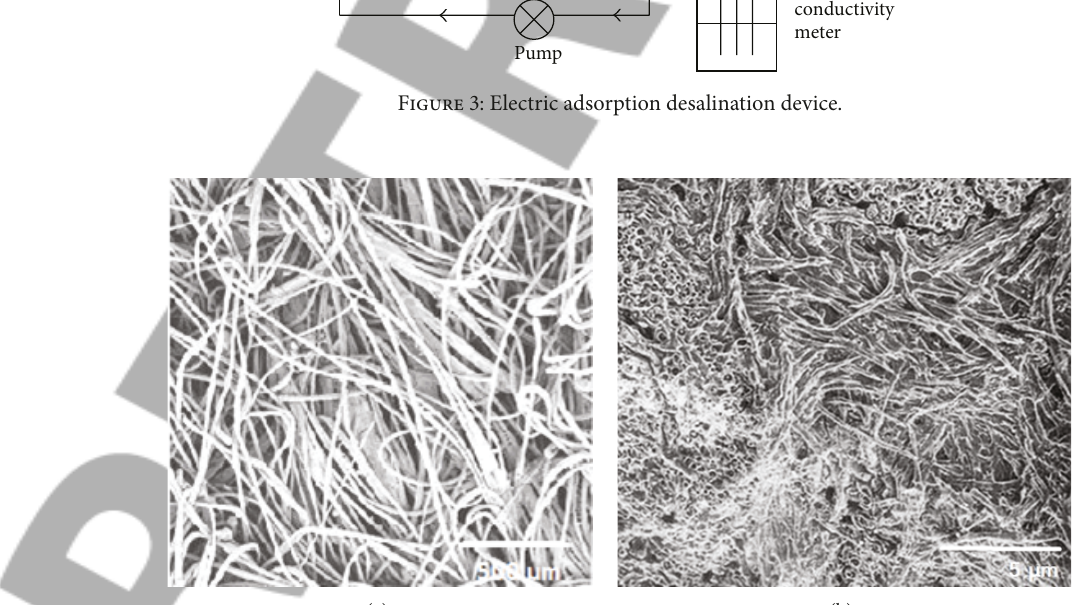
Figure 2: Electroadsorption modules.